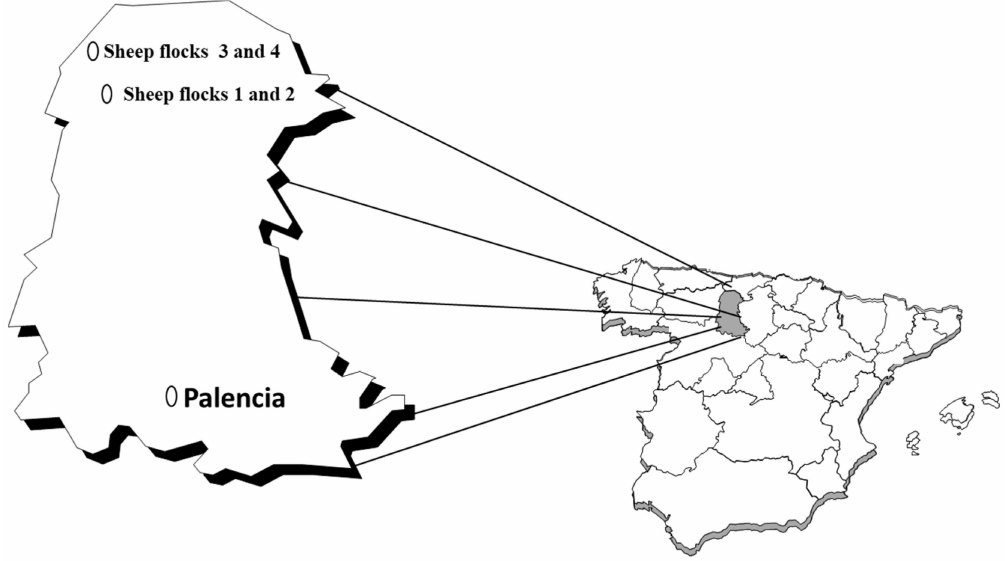
Figure 1. Palencia province, and the geographical distribution of the examined